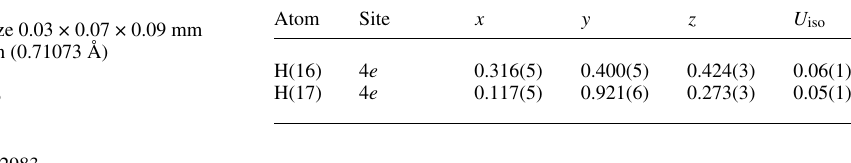
Table 1. Data collection and Crystal: